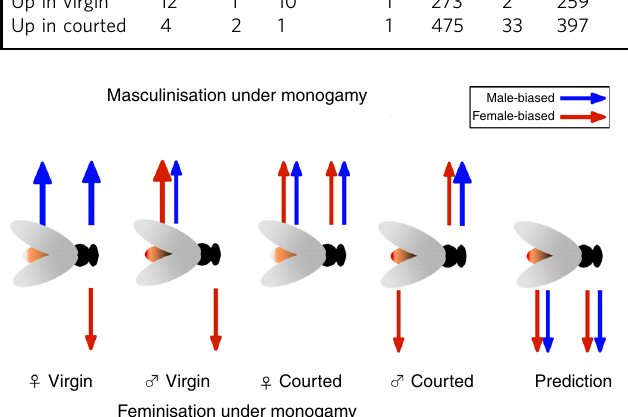
Fig. 4 Summary of the direction of change of sex-biased gene expression in heads and abdomens. The direction of the arrows indicates whether there is masculinisation (up) or feminisation (down), under monogamy. The colour of the arrows represents male (blue) or female (red) biased genes. Only cases when the means between sex-biased gene subsets differ signi fi cantly are represented by arrows, and thicker arrows indicate greater mean logFC, within the contrast. Most results do not conform to the prediction of masculinisation under monogamy (farthest